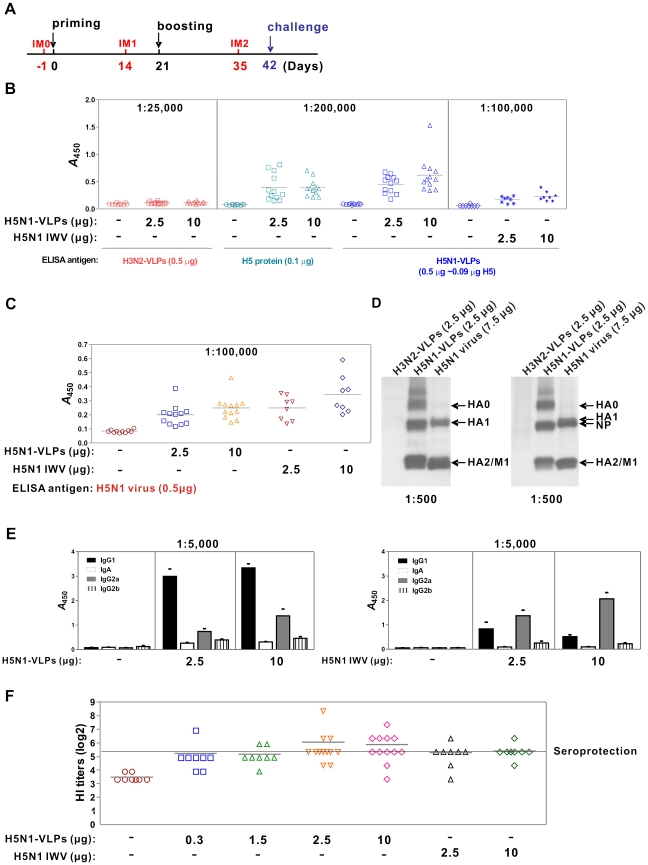
Humoral immune response of mammalian VLPs.(A) Regimen of prime and boost vaccination was followed by viral challenge. IM0, IM1, and IM2 represent the mouse serum collected before immunization (day -1), and 14 days after priming, and boosting, respectively. (B) The antigen-specific IgG antibodies from the serum of each mouse group taken at IM2 were assayed against distinct antigens of H3N2-VLP, H5 protein (recombinant baculovirus expressed), and H5N1-VLP (same as the immunization antigen) by ELISA after vaccination of H5N1-VLP or inactivated whole virus (IWV). Groups of mice (n = 8–12) were either intramuscularly immunized with 2.5 µg and 10 µg dose of VLPs, or IWV, as marked. The dilution of used serum samples in the ELISA assays are labeled at the top. H3N2-VLPs containing all the host cell proteins integrated into the VLP antigen but with different subtype of HA and NA was used as negative control, whereas the baculovirus-produced H5 protein constituted the positive control. The employed amounts of coating antigens are shown. (C) ELISA of serum IgG antibodies induced by H5N1-VLPs or IWV vaccines against H5N1 virus as ELISA antigen. (D) Western blot analysis of mice serum IgG antibodies elicited by either H5N1-VLP (left panel) or IWV (right panel) vaccines. The used antigens and individual amounts are indicated at the top of panels. (E) The specific IgG isotype and IgA elicited by VLPs and IWV vaccines were assayed using H5N1-VLP as ELISA antigen. (F) HI titer of each vaccinated mouse; mean values of the same group are plotted. HI titer of 40 was set as threshold of seroprotection.